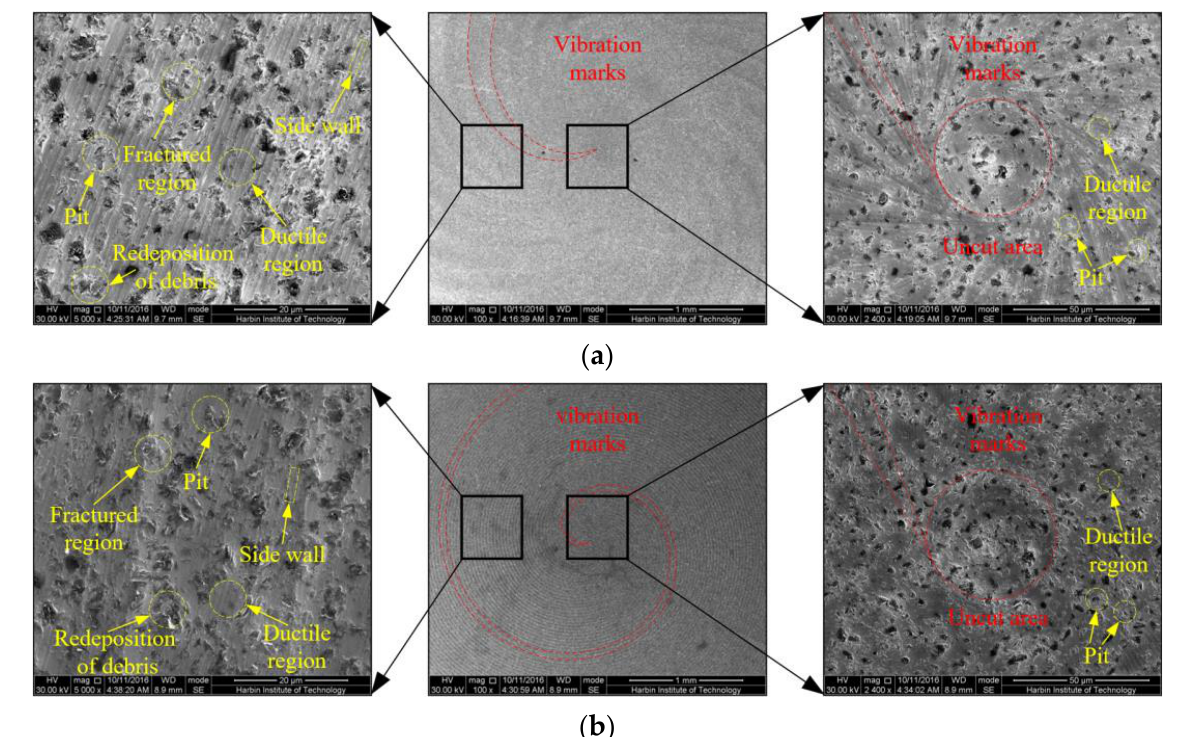
Figure 7. SEM micrographs of RB-SiC ground surface: ( a ) out of phase (phase shift = 0); ( b ) in phase (phase shift = 0.1).